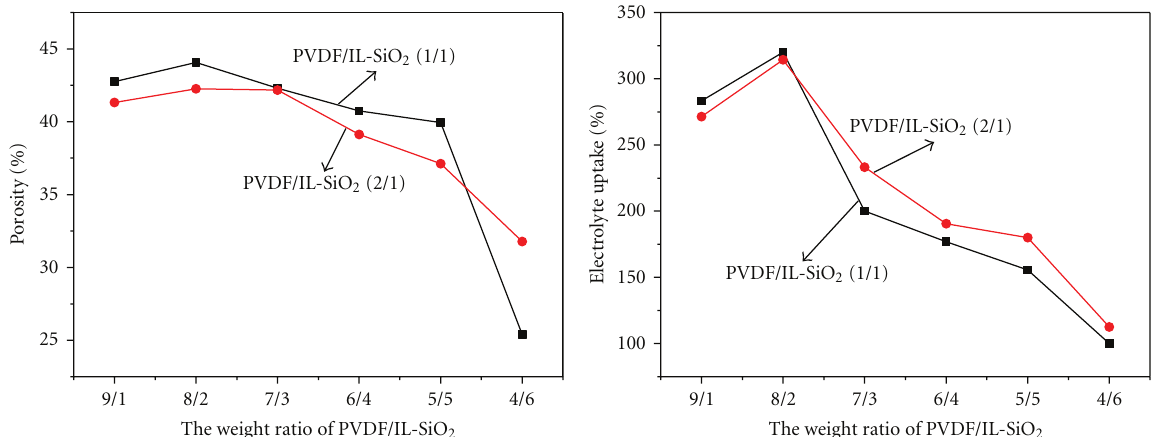
Figure 5: Porosity and electrolyte uptake of polymer membranes.